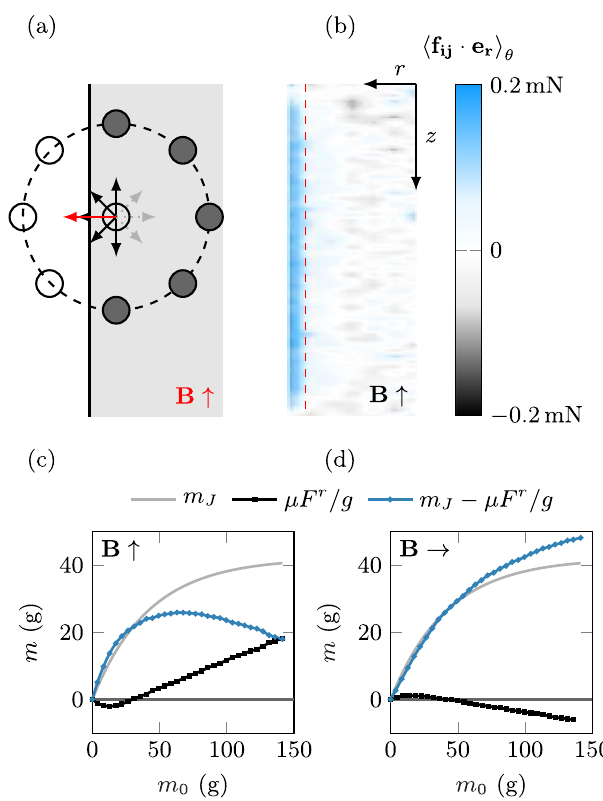
Fig. 3 Magnetic Janssen effect model. a The magnetic force on a particle within the packing, but off-the vertical axis, induced by neighboring ones (in dark gray), is non-zero and along the radial direction, due to the tube fi nite- size, and the non-compensation of the forces from the missing particles (in white). For a vertical magnetic fi eld, the resulting radial force is repulsive (red arrow), as con fi rmed by the right panel. b Numerical computation of a spatial ( r , z ) map of the magnetic pair-interaction radial component (averaged over the coordinate θ ) for a 10cm column, submitted to a magnetic fi eld of Ψ = 35. Model curves for each direction of the magnetic fi eld ( c vertical, d horizontal). The light gray line shows Janssen prediction; the black squares line is the result of the computed magnetic mass loss μ F r / g ; the blue circles line (difference of both curves) gives the predicted apparent mass of the